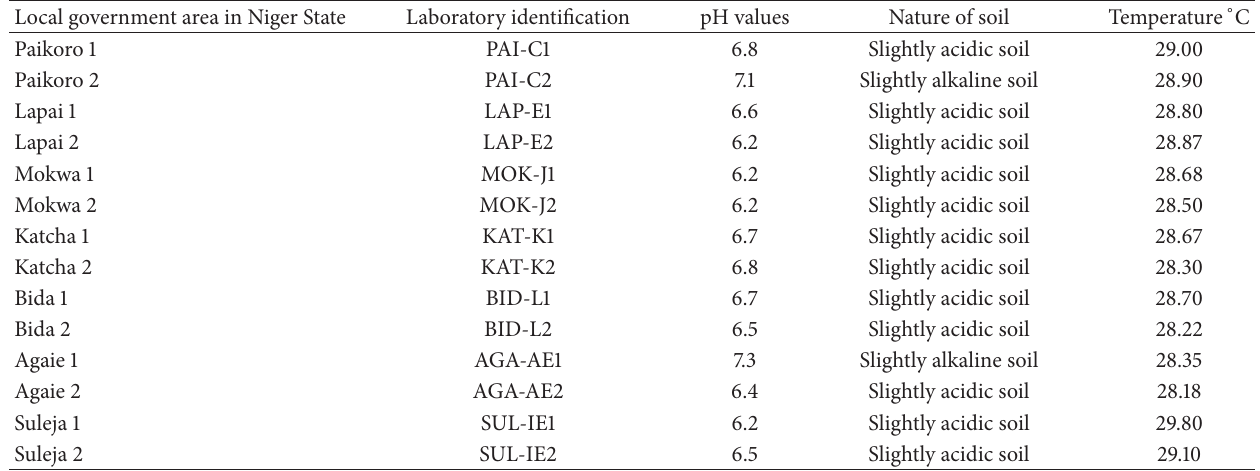
Table 3: Physical soil parameters in the sampling sites.